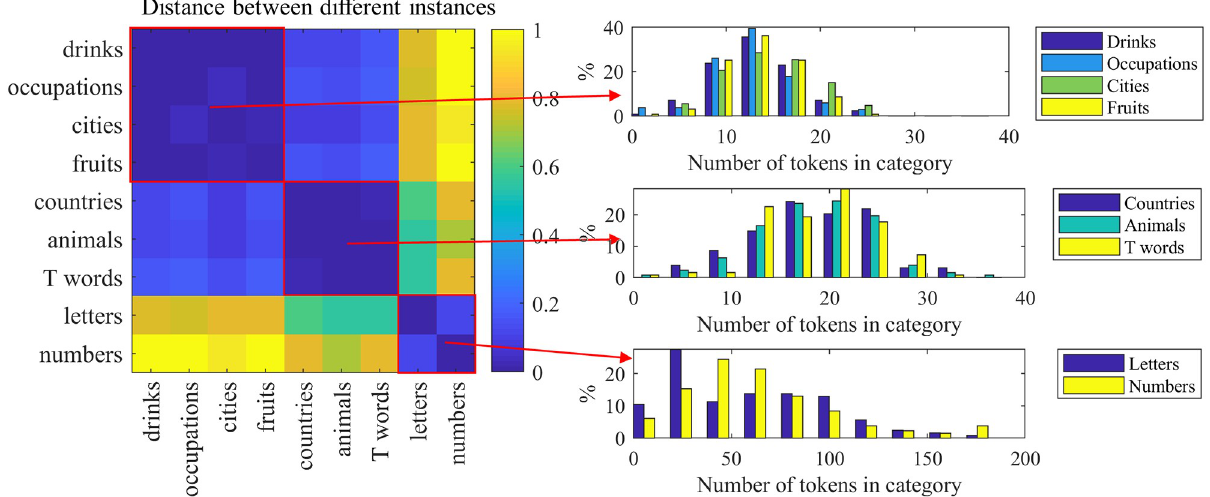
Fig 6. Fluency task: KL distances between distributions of the number of the tokens in category for different instances of the fluency task. The actual distributions are shown on the right.